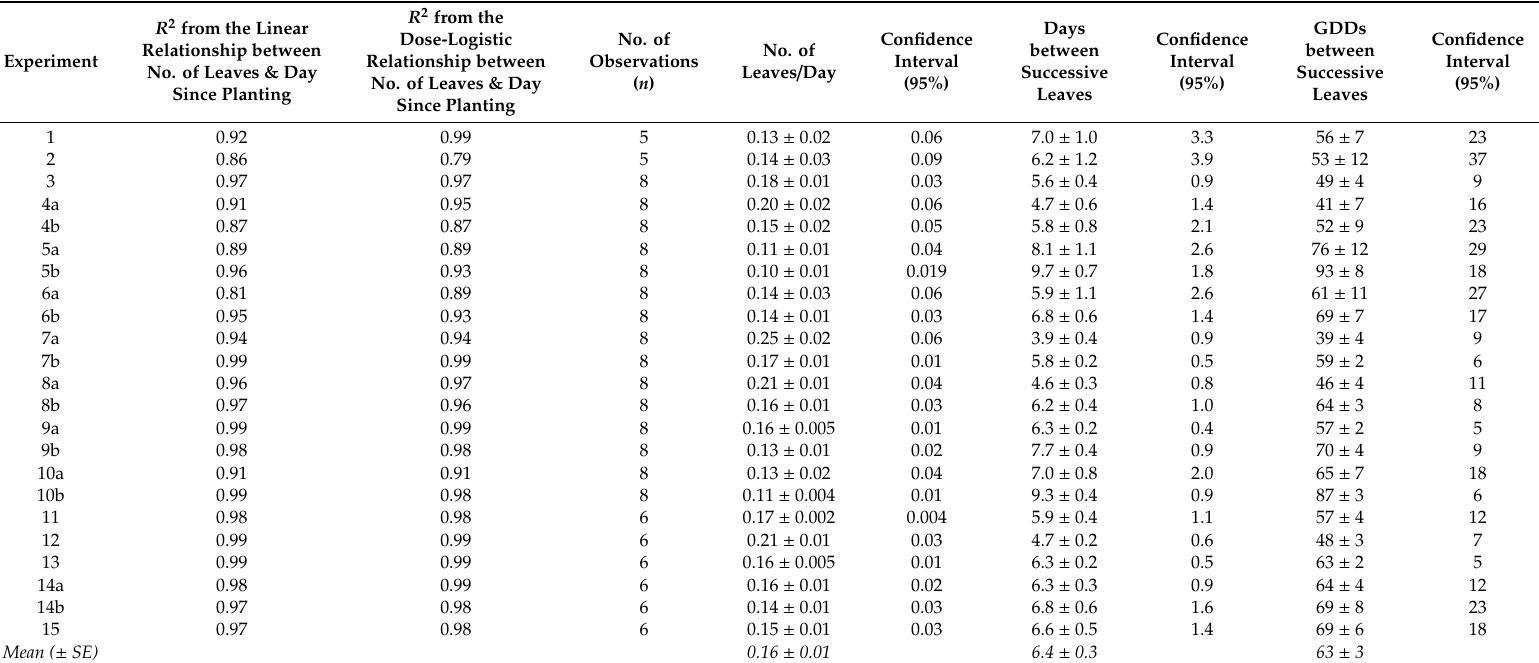
Table 3. Pattern and rate of leaf production in strawberries in Queensland. The number of leaves / day was calculated from the slope of the linear relationship between the number of leaves / plant and the day since planting. The interval between successive leaves was calculated from the slope of the linear relationship between day since planting and the number of leaves / plant. The number of growing degree-days (GDDs) between successive leaves was calculated from the slope of the linear relationship between GDDs and the number of leaves / plant, using a base temperature of 7 ◦ C. Data are presented as mean values ± SEs (standard errors). Confidence intervals were calculated from the SEs. Details of the experiments are provided in Tables 1 and